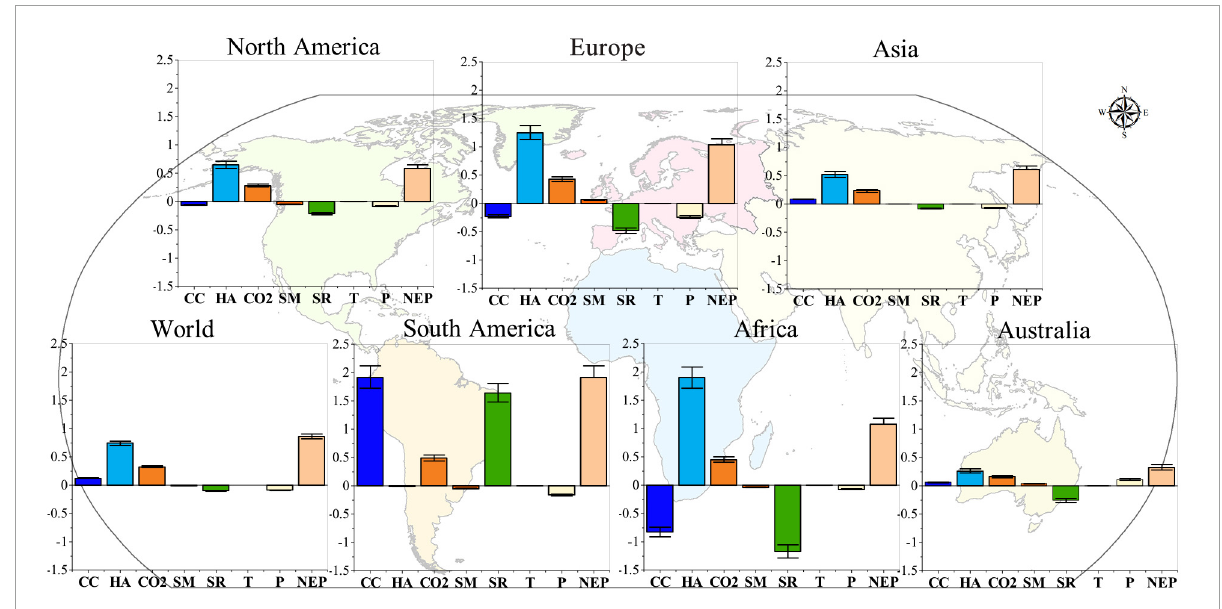
FIGURE6 The HA_con and CC_con to NEP in the world and six